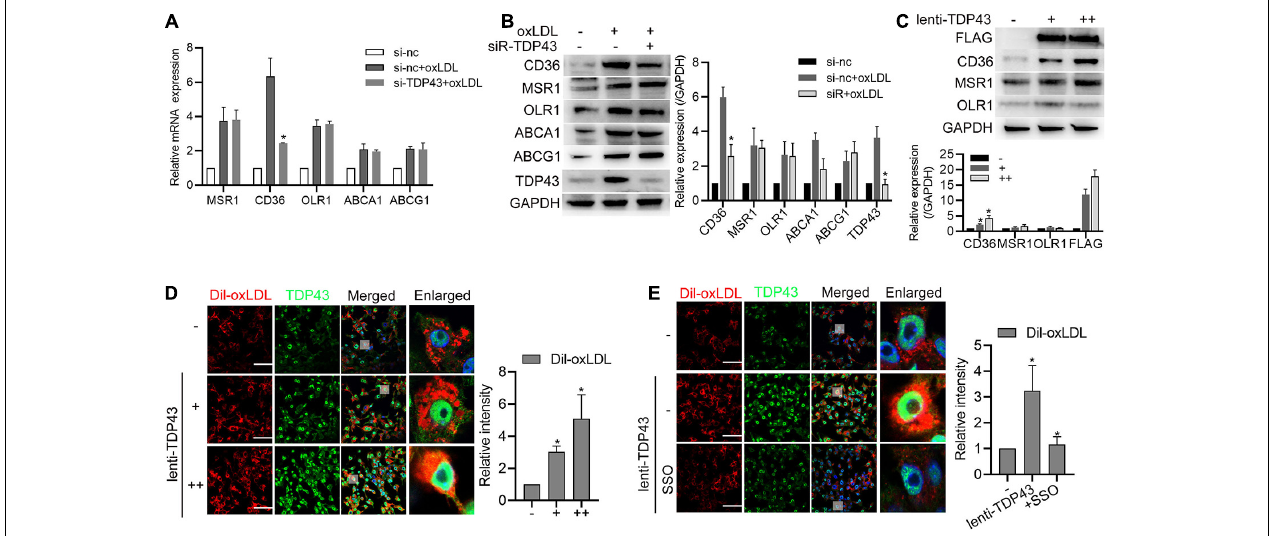
FIGURE 5 | Transactive response DNA-binding protein ∼ 43 kDa (TDP43) strengthens lipid uptake of macrophages through promoting Cluster of Differentiation 36 Receptor (CD36) expression. (A) qPCR detection of lipid uptake and export related genes in macrophages transfected with si-TDP43 or si-nc for 24 h and later incubated with 40 µ g/mL oxLDL for 24 h. Data are represented as means ± SD ( n = 3; * P < 0.05 vs. si-nc + oxLDL group). (B) Western blot analysis of lipid uptake and export related proteins in macrophages transfected with si-TDP43 or si-nc for 24 h and later incubated with 40 µ g/mL oxLDL for 24 h. Data are represented as means ± SD ( n = 3; * P < 0.05 vs. si-nc + oxLDL group). (C) Western blot analysis of CD36, MSR1, and OLR1 protein expressions in macrophages infected with lenti-control or lenti-TDP43 for 48 h. Data are represented as means ± SD [ n = 3; * P < 0.05 vs. lenti-TDP43 (–) group]. (D) Immunofluorescence analysis